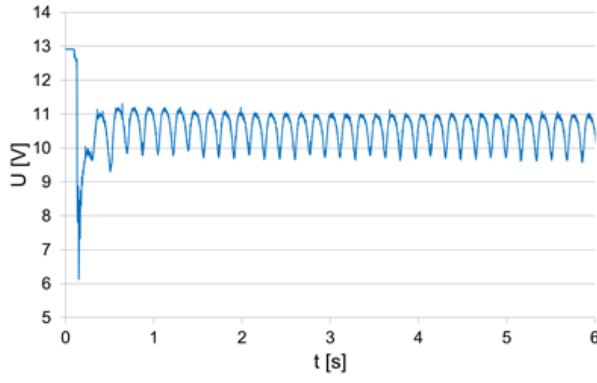
Fig. 8. The course of voltage measured at the terminals of a loaded battery To assess the state of the electric starter, it is necessary to know the engine resistance torque. The basic meaning in the proposed method of the starter state assessment is to determine its actual power characteristic. The course of the power characteristics of the starter similar to the parabola indicates the possibility of their description using the sec- ond-degree polynomial in depending on the current.